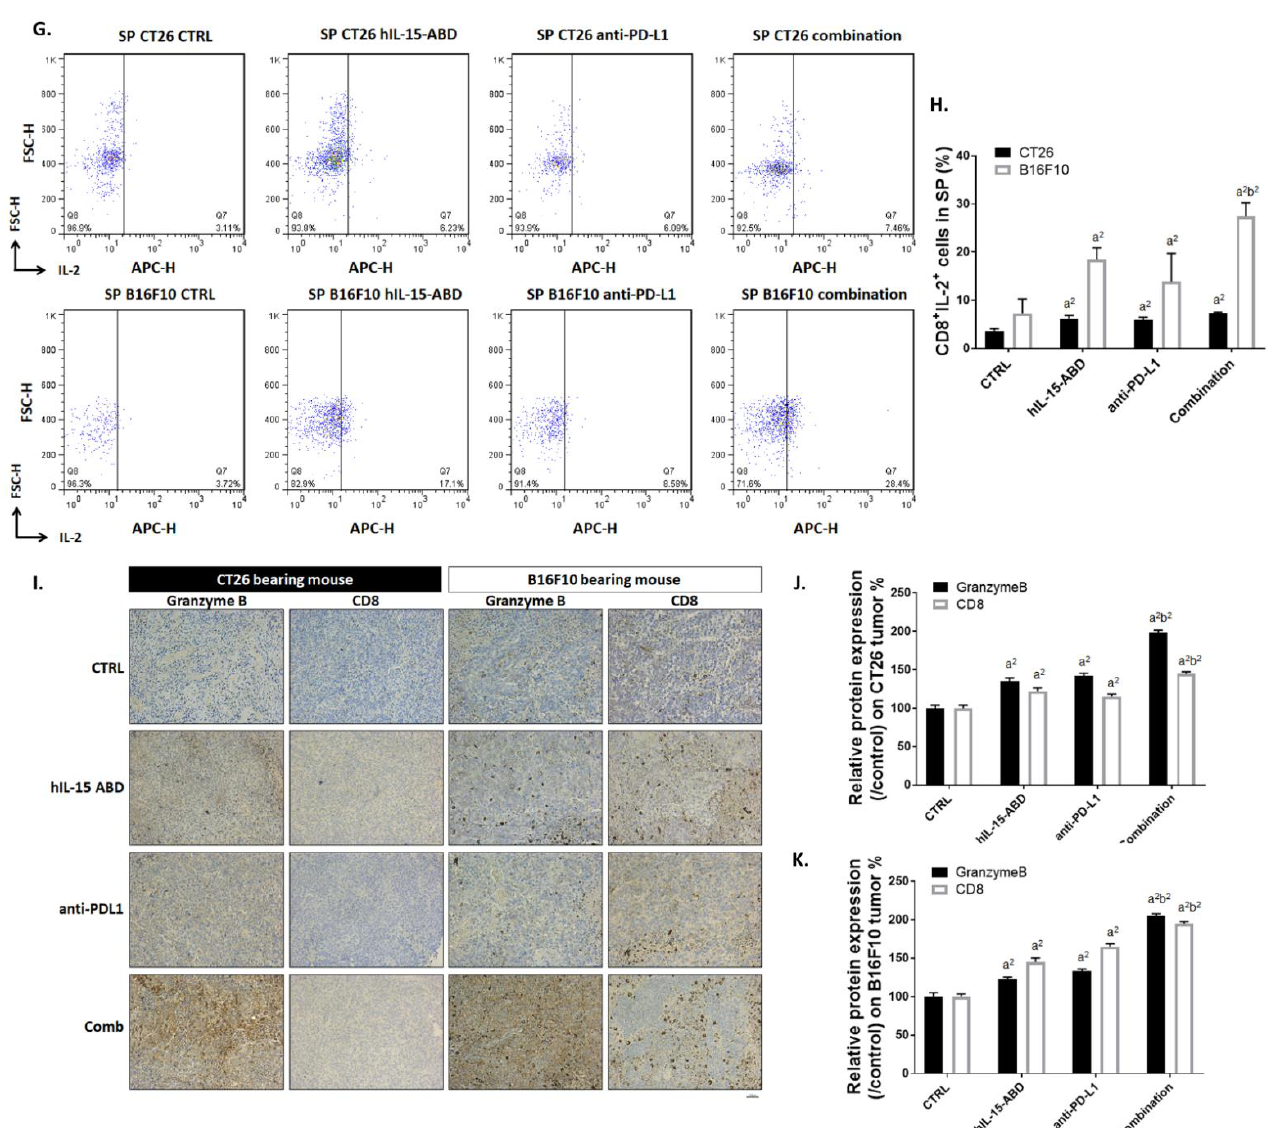
Figure 5. hIP-15-ABD offer a reinforce role of increasing anti-PD-L1 antibody induced CD8+ T cells activation. ( A ) Flow cytometry pattern and ( B ) quantification results of CD8+/IFN-γ + cells from TDLN. ( C ) Flow cytometry pattern and ( D ) quantification results of CD8 + /IFN-γ + cells from SP. ( E ) Flow cytometry pattern and ( F ) quantification results of CD8 + /IL-2 + cells from TDLN. ( G ) Flow cytometry pattern and ( H ) quantification results of CD8 + /IL-2 + cells from SP. ( I ) Granzyme B and CD8 immunohistochemistry (IHC) staining images and relative proteins quantification level of ( J ) CC and ( K ) melanoma are displayed. (a 1 p < 0.05, a 2 p < 0.01 vs. CTRL; b 1 p < 0.05, b 2 p < 0.01 vs. hIL15-ABD and anti-PD-L1; scale bar = 100 μm).